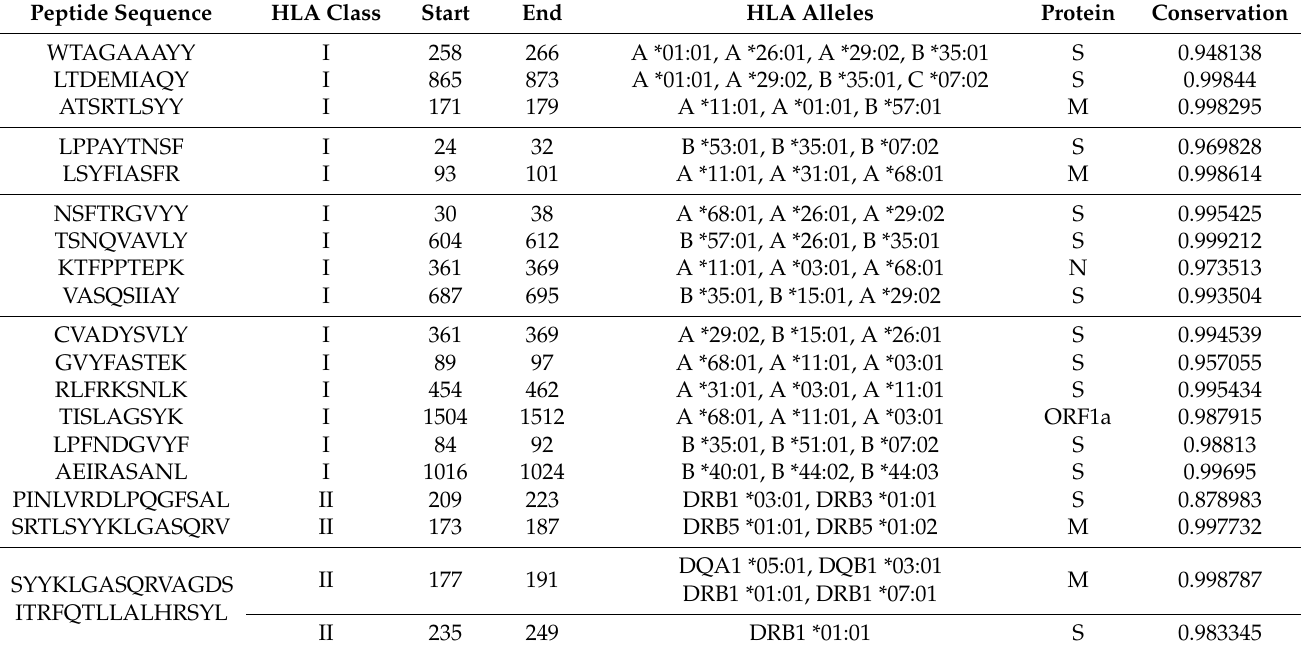
Table 1. Selected HLA class I and class II-restricted epitopes based on their conservation and the number of allele